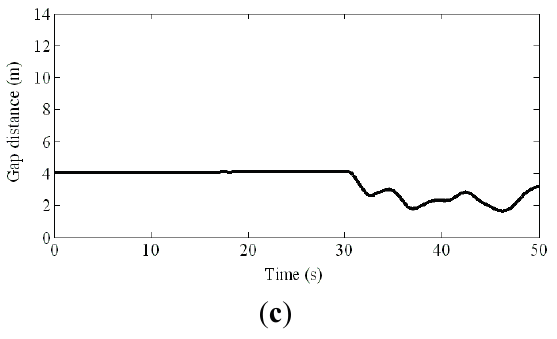
Figure 6. Variable gap distances in the automatic driving. ( a ) 12 m gap distance; ( b ) 8 m gap distance; ( c ) 4 m gap distance.